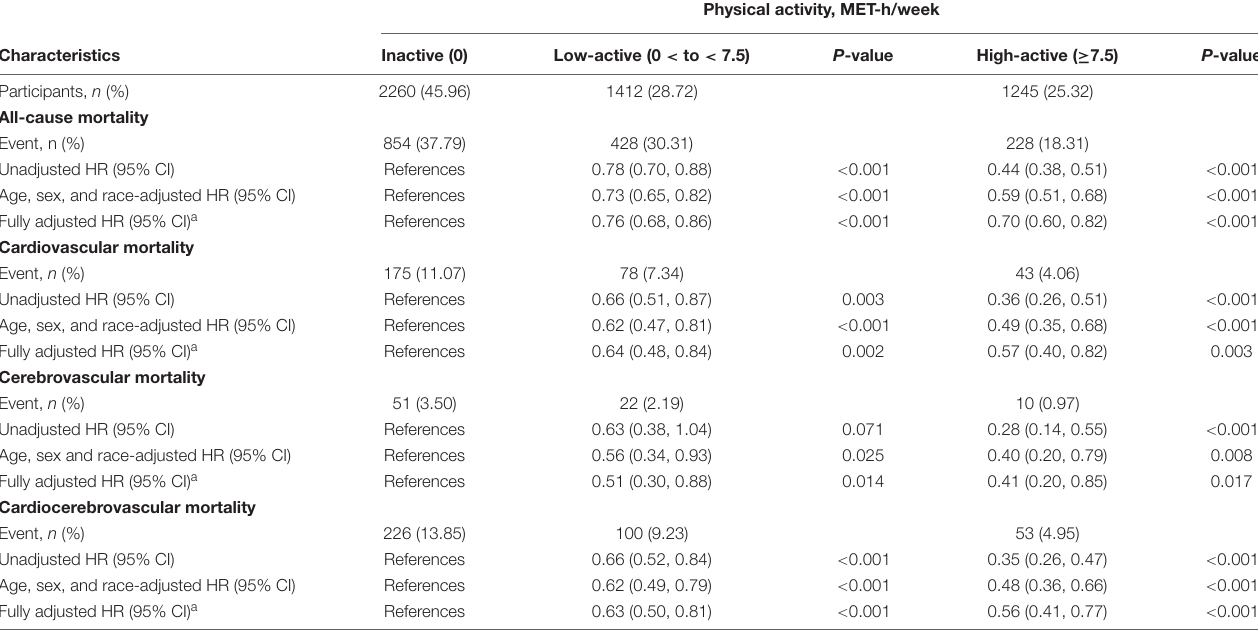
TABLE 2 | PA and risks for all-cause mortality and cardiocerebrovascular in patients with hypertension.